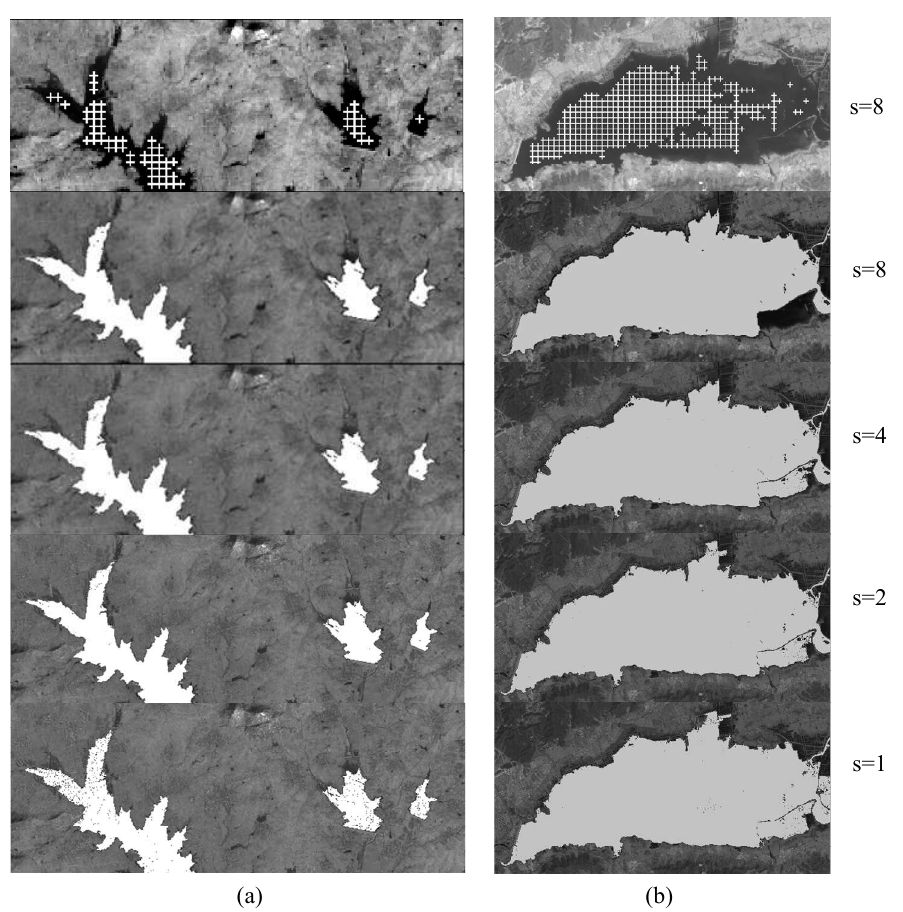
Figure 7. The seed points on the top pyramid image and ROIs on all pyramid images, s is the down sampling scale. ( a ) Image pair block 1. ( b ) Image pair block 2.